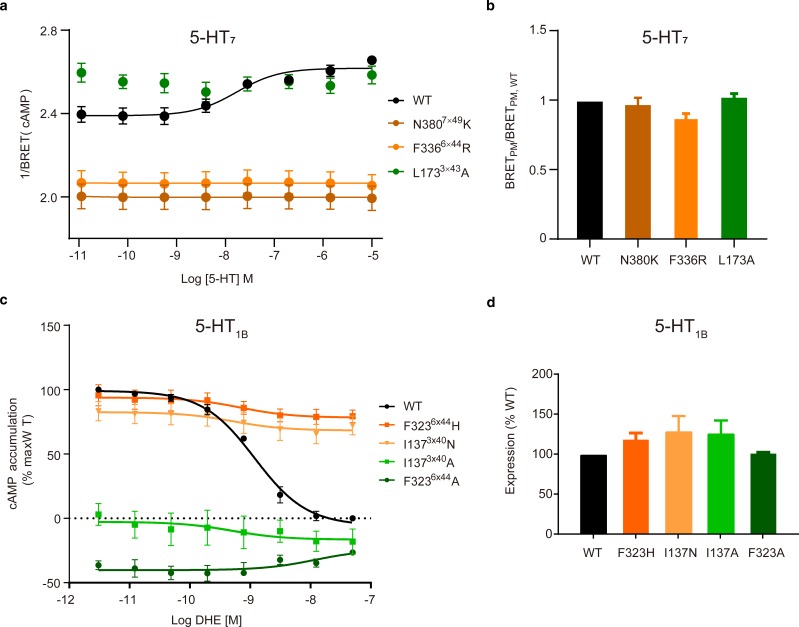
Experimental validation of common activation pathway-guided CAM/CIM design for Gs-coupled 5-HT7 and Gi-coupled 5-HT1B receptors.(a) cAMP assay of Gs-coupled 5-HT7 receptor used an EPAC-based BRET cAMP sensor (n = 6). WT, CAMs and CIMs are colored by black, orange and green, respectively. (b) Trafficking assay measured WT and mutant 5-HT7 receptors in the plasma membrane (PM). (c) cAMP measurement of 5-HT1B receptor. CAMs and CIMs are shown in green and orange, respectively. (d) Cell surface expression of mutant 5-HT1B receptors relative to that of WT. DHE, dihydroergotamine.